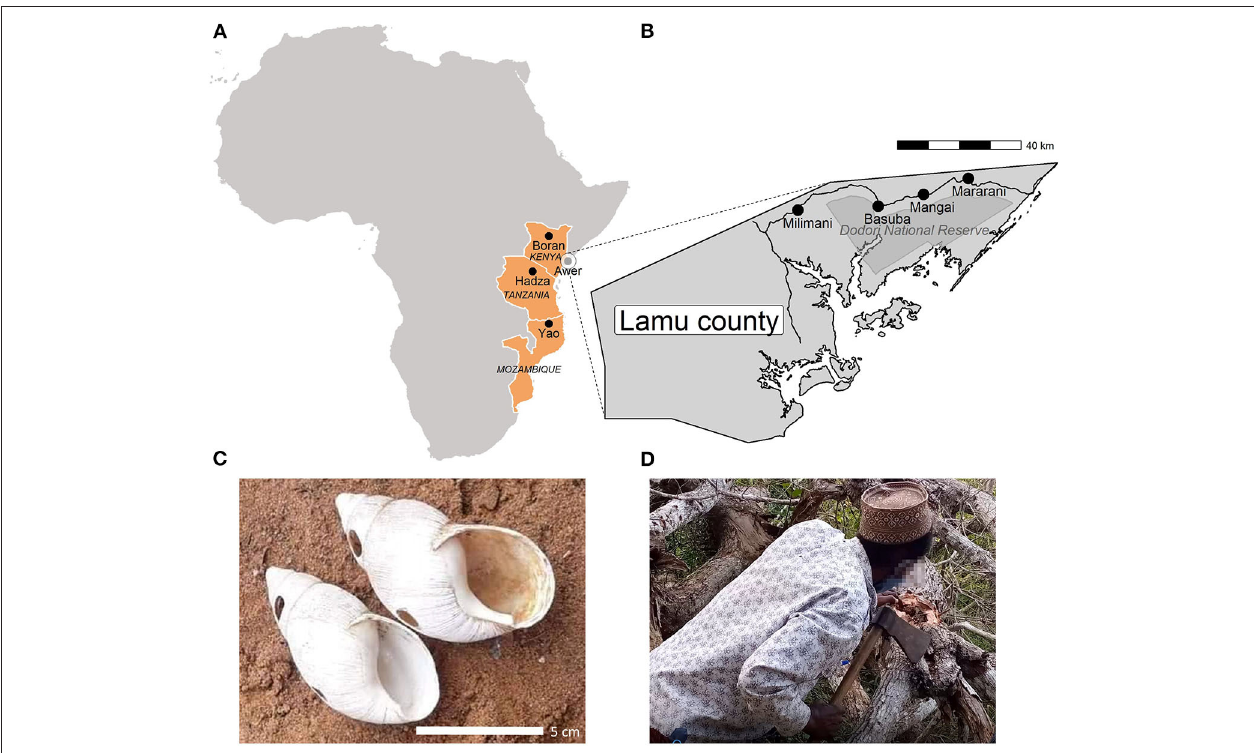
FIGURE 1 | By describing the Awer honey-hunting culture with honeyguides, we obtain a better picture of the human cultural variation which continues to sustain human-honeyguide mutualism. (A) The locations of African cultural groups in which honey-hunting with greater honeyguides (Hadza, Yao, and Boran) has been the subject of scientific research (see citations in main text); (B) the locations of the four villages in Lamu County along the Hindi-Bodhei-Basuba-Kiunga road in coastal Kenya where IG interviewed six honey-hunter interviewees; (C) Giant African Land Snail shells ( Achatina fulica ) with two pierced holes used by Awer honey-hunter to generate whistles to attract honeyguides; (D) An Awer honey-hunter using an axe to harvest a stingless bees’ nest (we did not witness the harvest of a honeybees’ nest). Photographs by